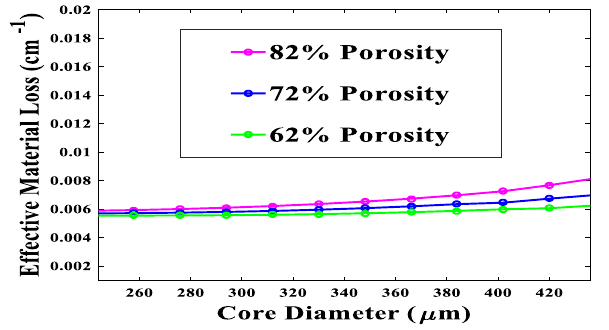
Fig. 8 Scattering loss (dB/km) versus frequency (THz) at optimum design parameters